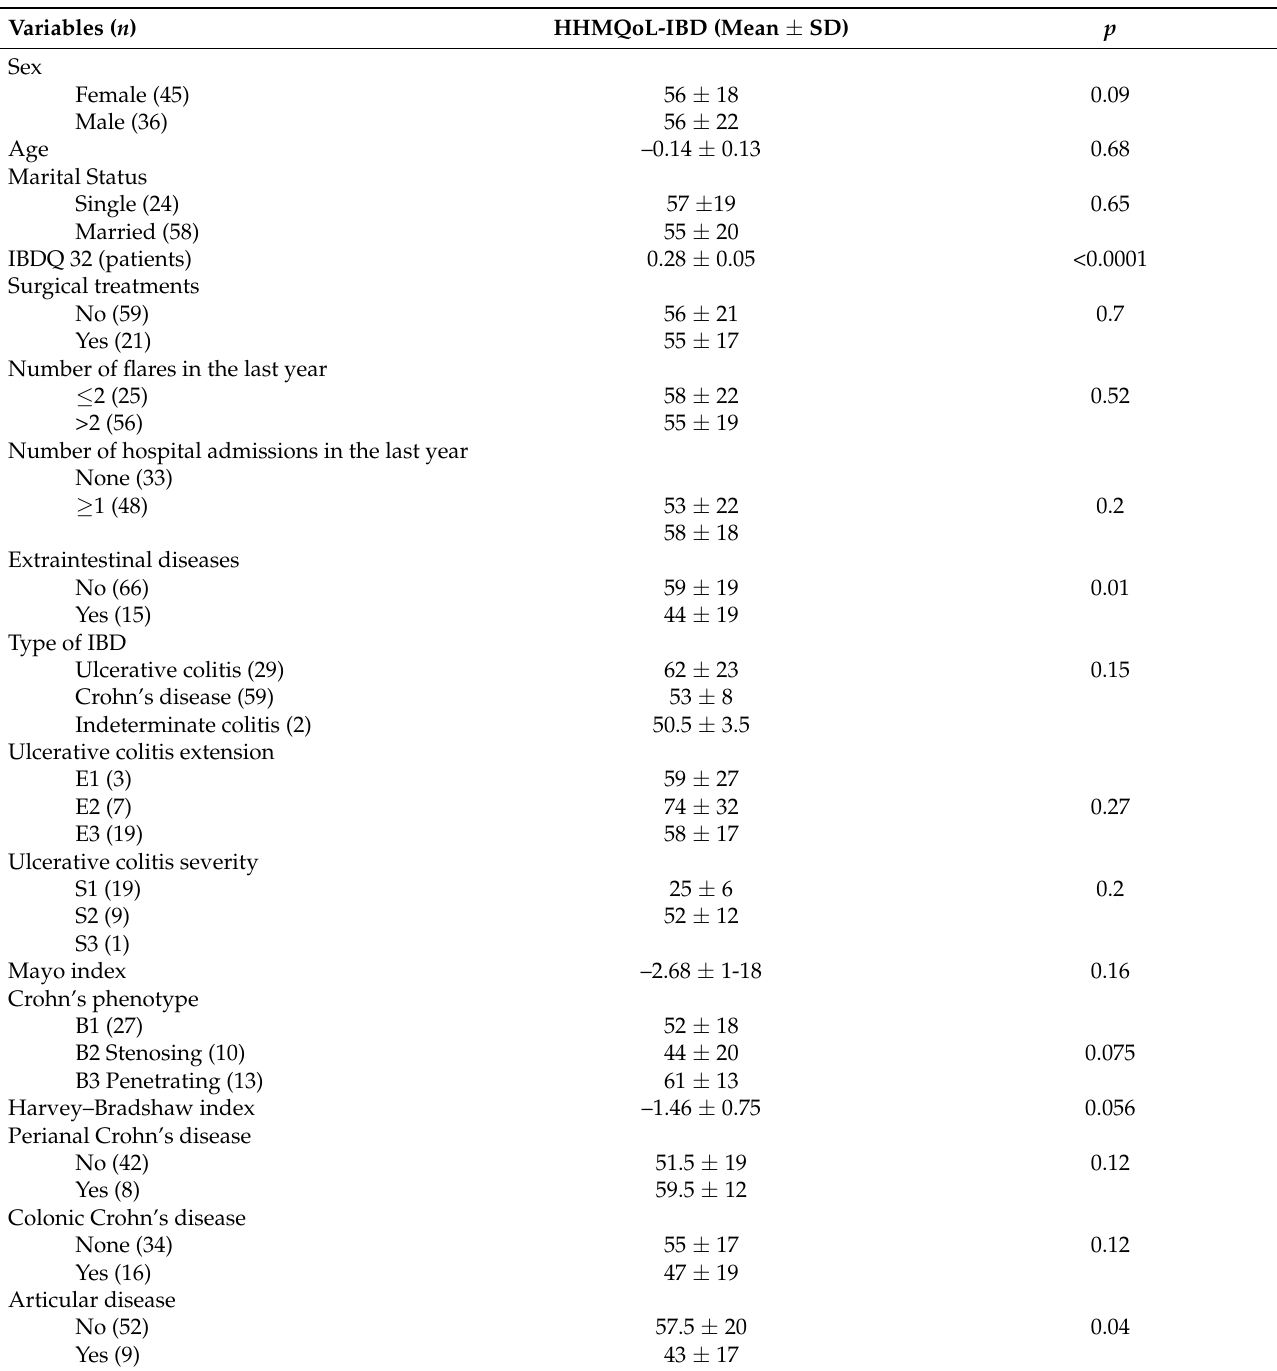
Table 4. Univariate analysis of factor potentially related with quality of life in